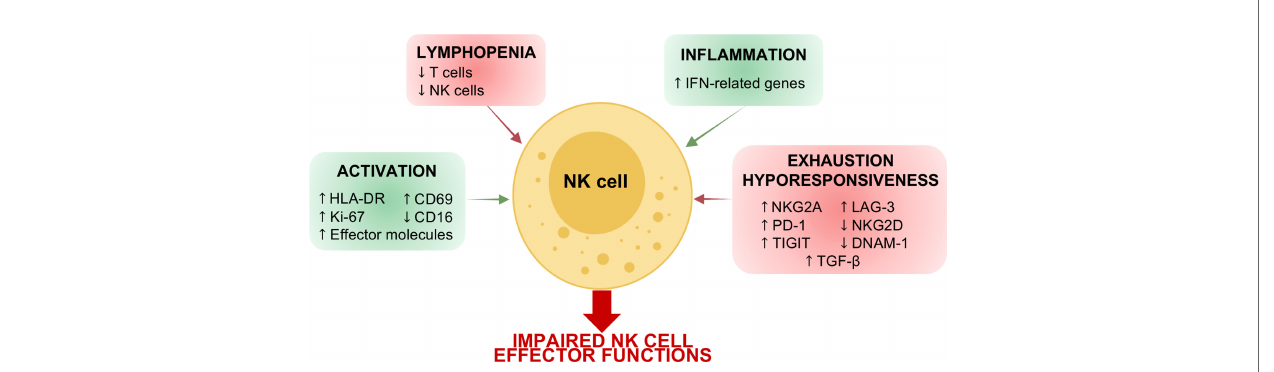
FIGURE 1 | Schematic representation of COVID-19 effects on NK cells. Acute SARS-CoV-2 infection affects the number of circulating NK cells and their phenotype. Indeed, due to the local and systemic in fl ammation, NK cells in COVID-19 patients are characterized by a signature attributable to cell activation and in fl ammation as well as to cell exhaustion and hyporesponsiveness. These alterations in NK cell phenotype determine an impairment of NK cell effector functions in terms of IFN- g and TNF- a production, degranulation cytolytic potential and ability to control virus